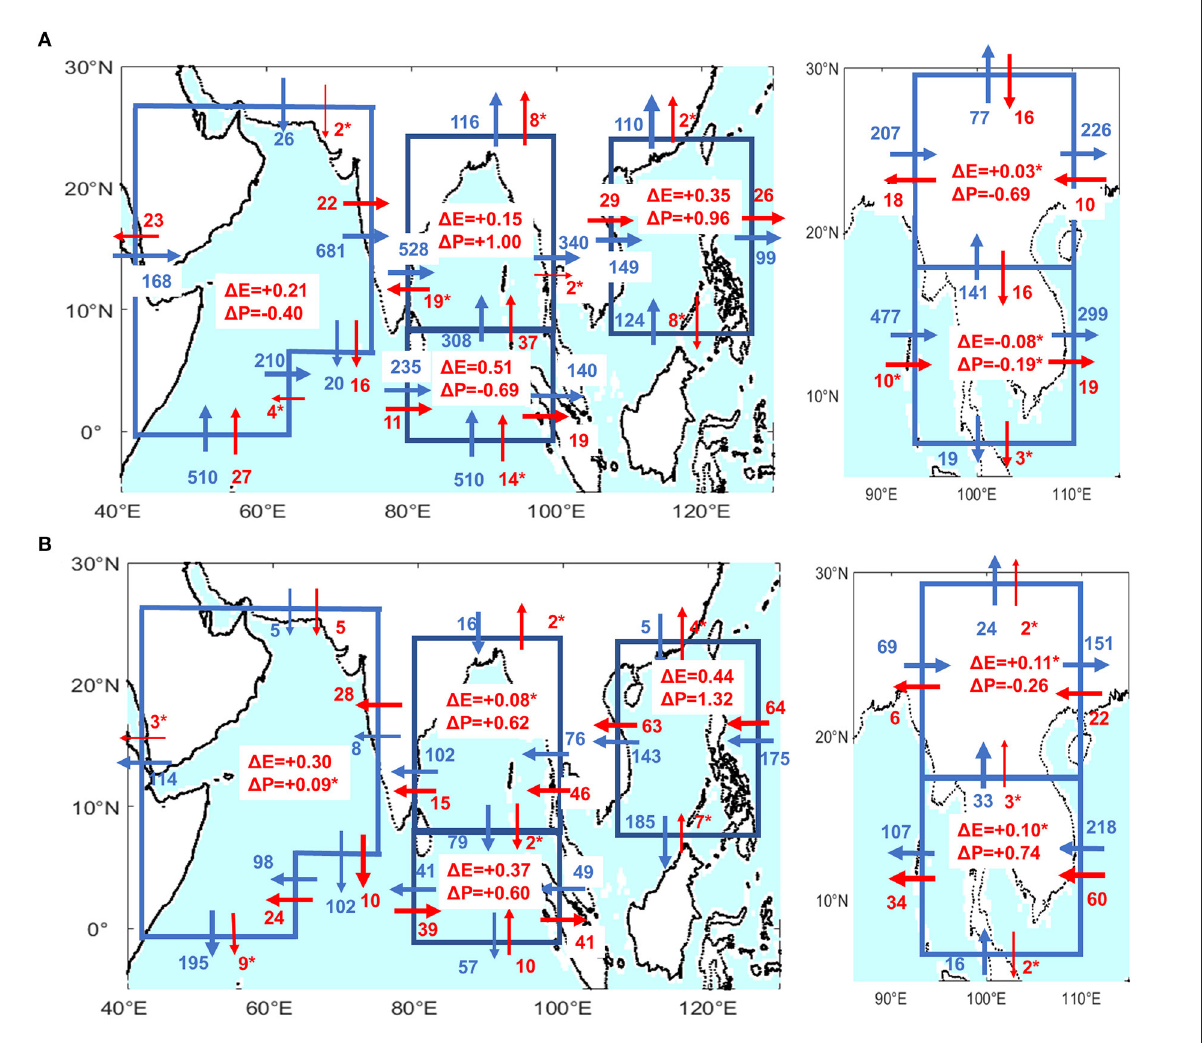
FIGURE11 Linear trends (1979–2018) in area-averaged evaporation 1 E (mm/day/40 years) and precipitation 1 P (mm/day/40 years) and atmospheric water vapor transport integrated along the zonal/meridional boundaries (in 10 6 kg/s/40 years) of four oceanic regions (Arabian Sea, Northeast equatorial region (0–8 ◦ N), Bay of Bengal, and South China Sea) and for the south (7–18 ◦ N) and north (18–30 ◦ N) parts of the MSEA in (A) summer (JJA); and (B) winter (DJF), based on the ERA5 re-analysis. Blue and red vectors and accompanied values denote climatological mean and total change in transport direction and magnitude, respectively, over 1979–2018. Symbol ‘*’ denotes trends that are not statistically significant at the 95% confidence